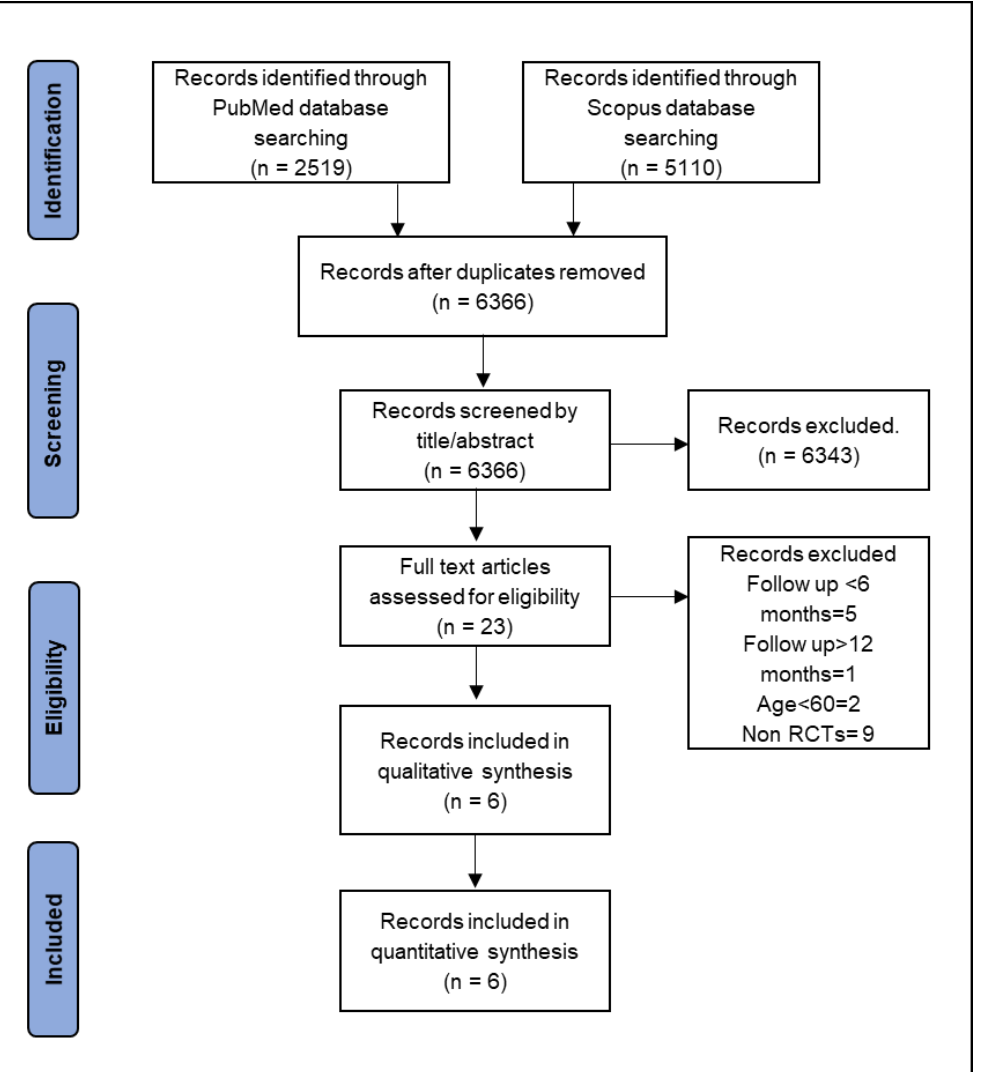
Figure 1. Flow chart of articles screening.